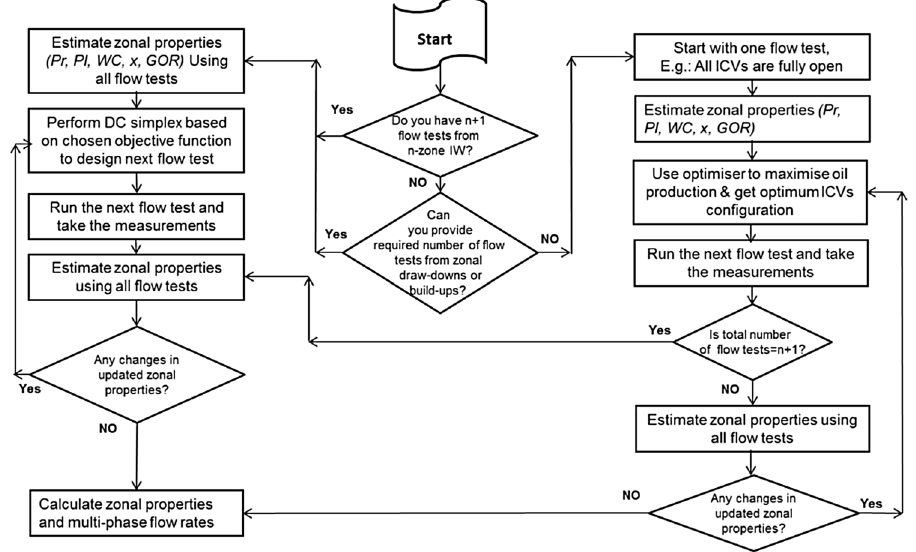
Fig. 6 Integrated control and monitoring workflow in multi- zone I-well